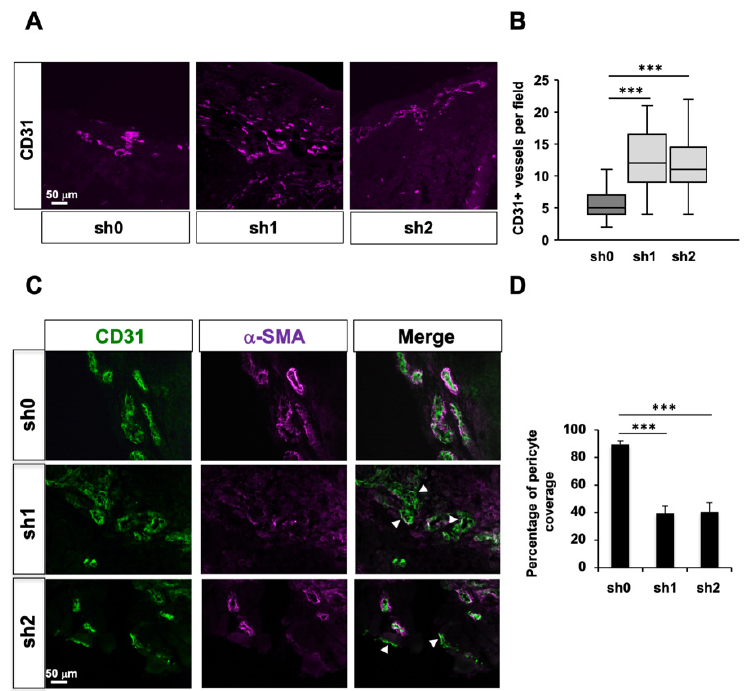
Figure 5. Stau1 depletion affects tumor angiogenesis. ( A ) CD31 staining on cross-sections of H460 tumors expressing sh0, sh1 and sh2 shRNAs. ( B ) Stau1 knock-down increased the number of blood vessels as shown by the quantification. ( C ) Maturity of blood vessels was evaluated by α -SMA and CD31 immunostaining (white arrows show blood vessels) and ( D ) quantification of pericyte coverage revealed a lack of pericyte coverage of tumor blood vessels irrigating Stau1-KD tumors (sh1 and sh2). The analysis was carried out on 5 mice for each of the 3 groups for which 5 fields were counted for every 6 slices observed. *** p <